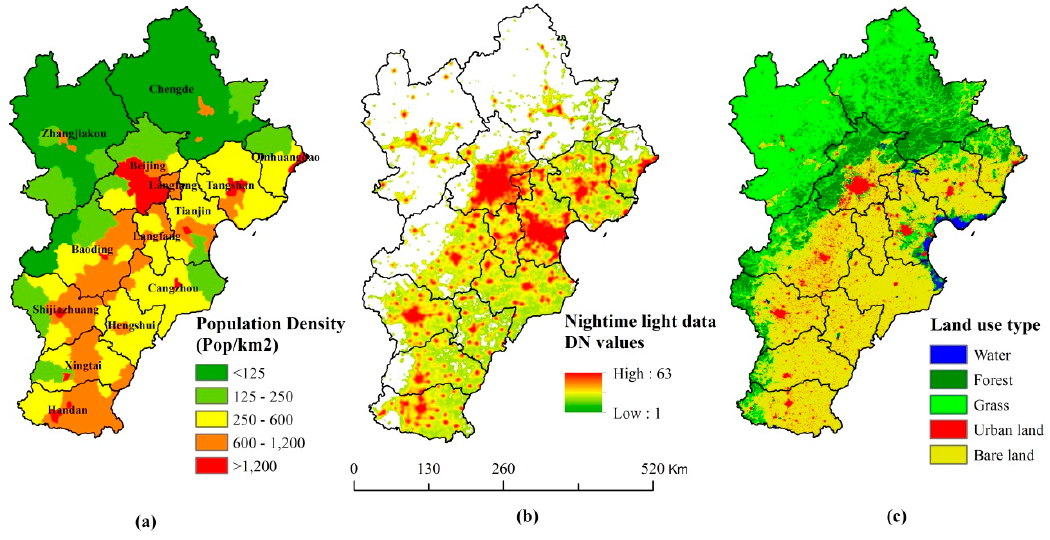
Figure 2. ( a ) Census data, ( b ) DMSP/OLS NTL, and ( c ) land use data of the study area in